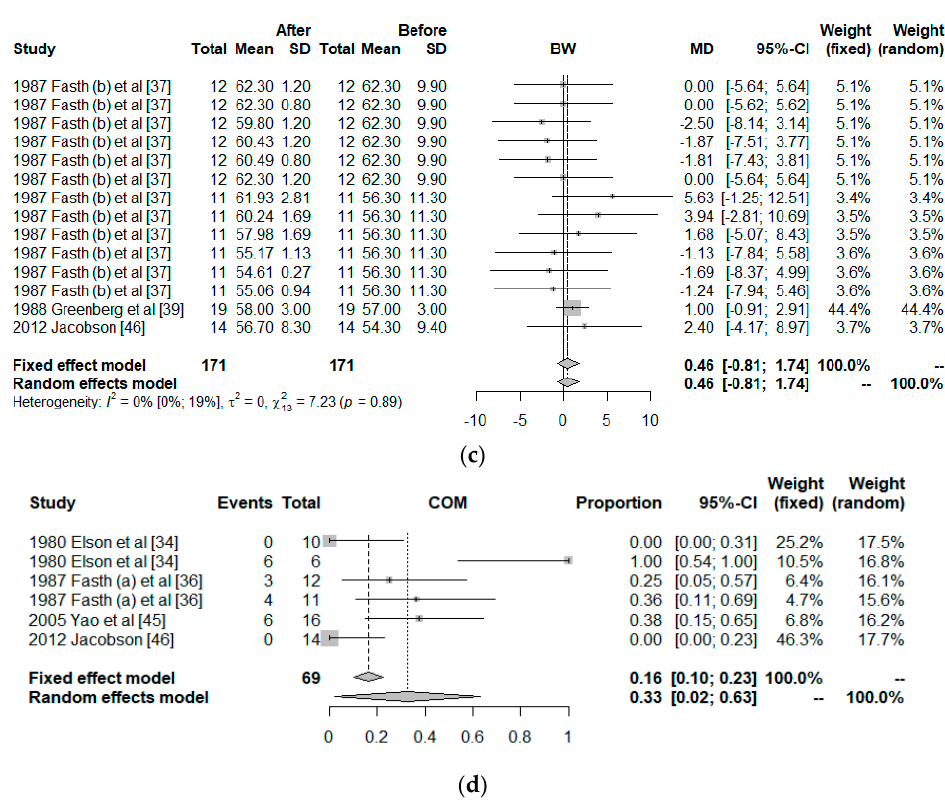
Figure 3. Forest plot for: ( a ) Crohn’s Disease Activity Index (CDAI), ( b ) Albumin, ( c ) Body weight (BW), and ( d ) Postoperative complications (COM). Table 3. Influence analysis in a meta-analysis using the leave-one-out method (Random e ff ect). Meta-Analysis for: E ff ect Size